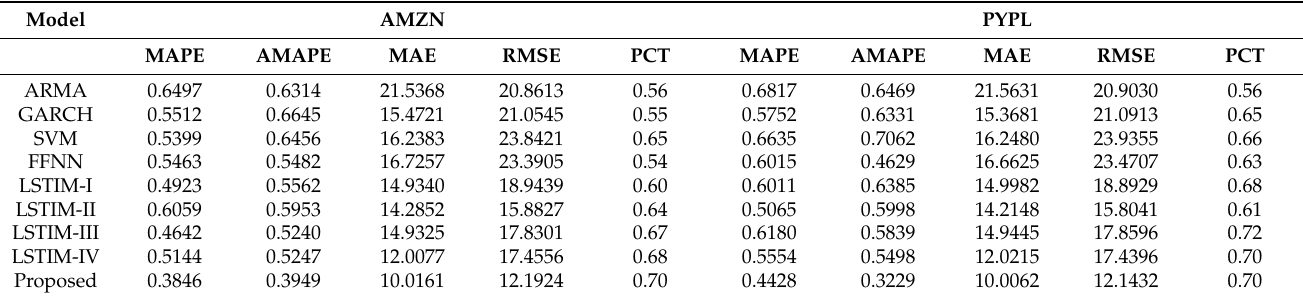
Table 18. Prediction performance for 300 days: AMZN and PYPL.